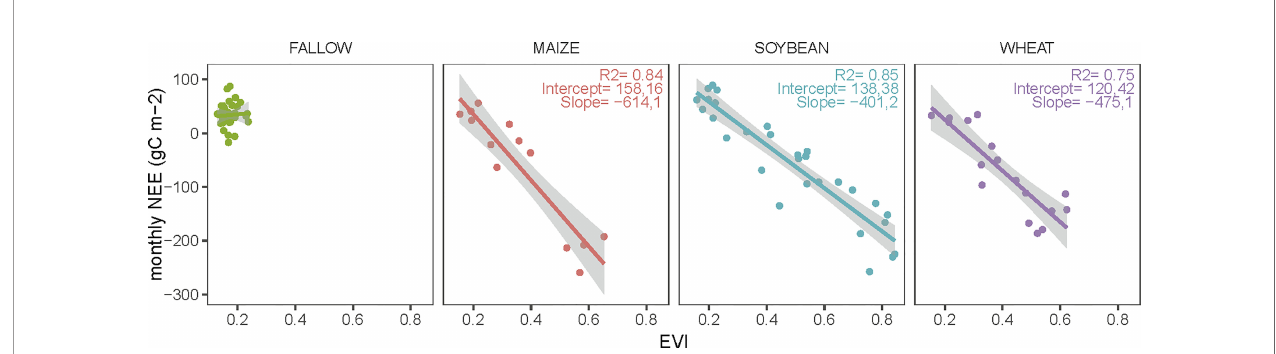
FIGURE 3 | Individual linear regression models between monthly mean EVI and monthly accumulated NEE in EC site for each land cover/crop type. Insets include coef fi cient of determination ( R 2 ), intercept, and slope for corresponding land cover/crop type. The fallow linear regression model was not statistically signi